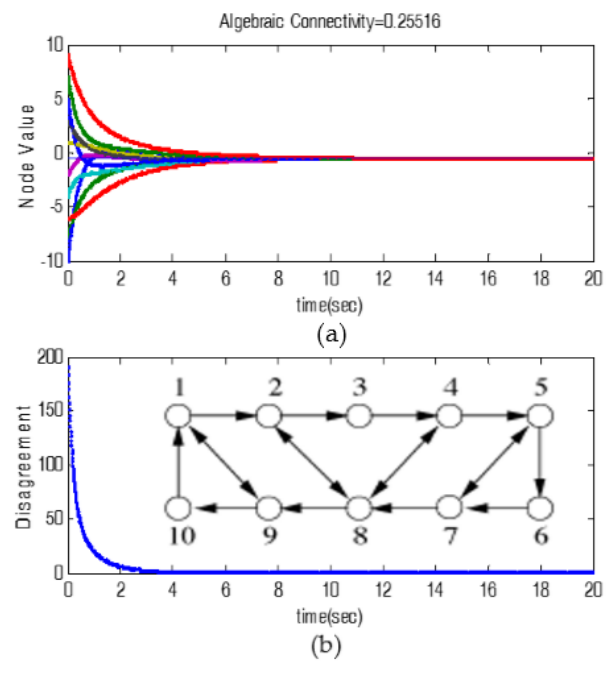
Figure 3. Balanced Multi ‐ Agent Consensus. ( a ) Node Value vs time ( b ) Disagreement vs time.